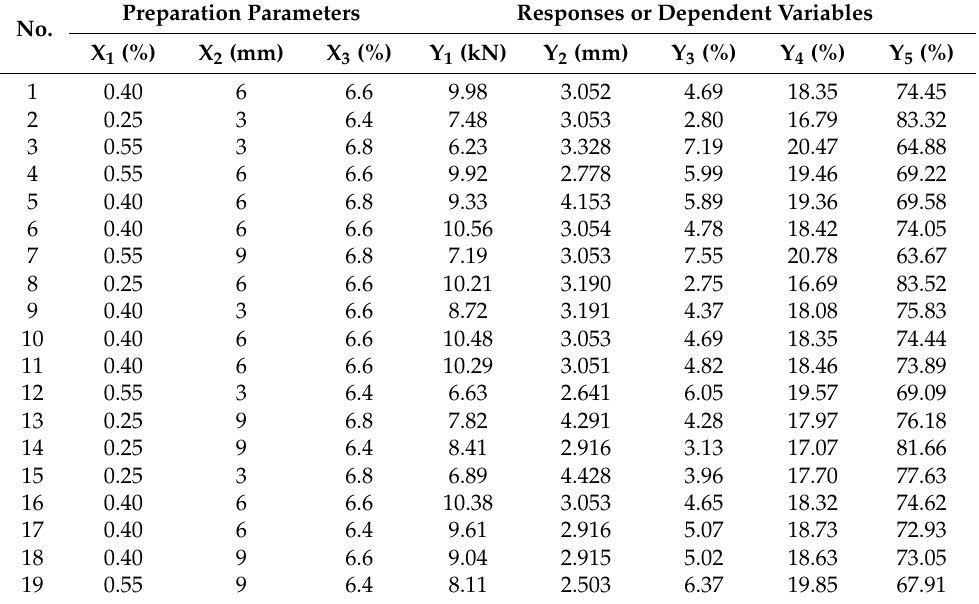
Table 1. Experimental design and outputs by response surface methodology (RSM) [16].